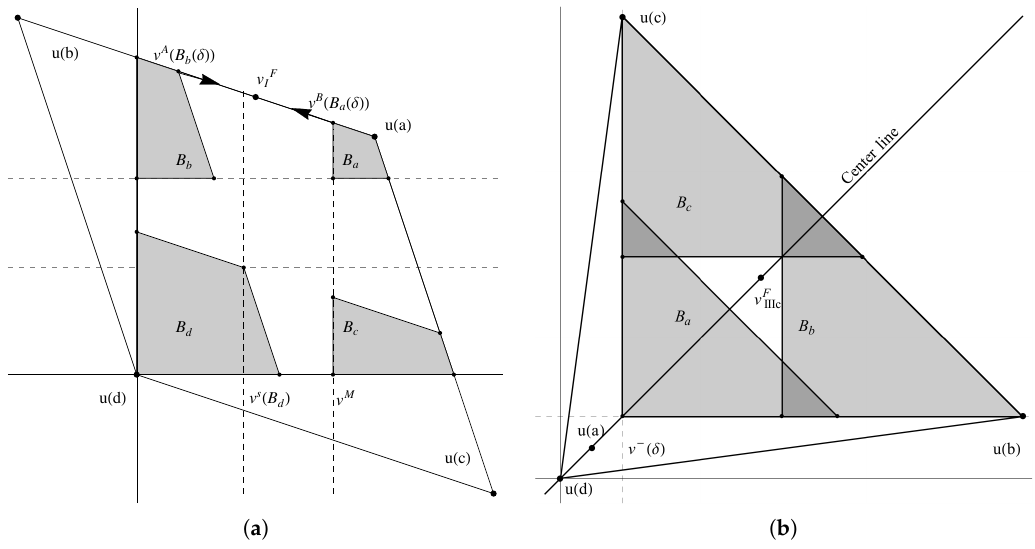
Figure 2. Admissible payoffs in Groups I and IIIc. The shaded areas show the B a sets for a ∈ A . ( a ) Group I; ( b ) Group